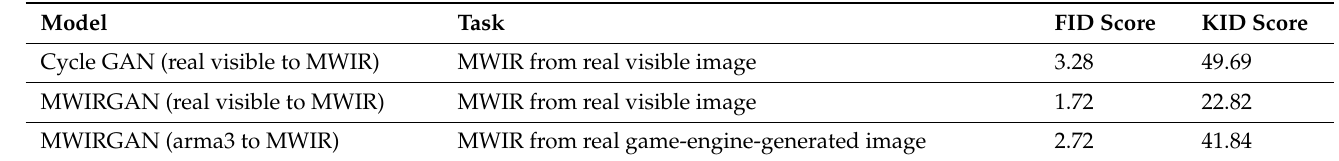
Table 3. Quantitative evaluation of the translation from game-engine-generated images to MWIR